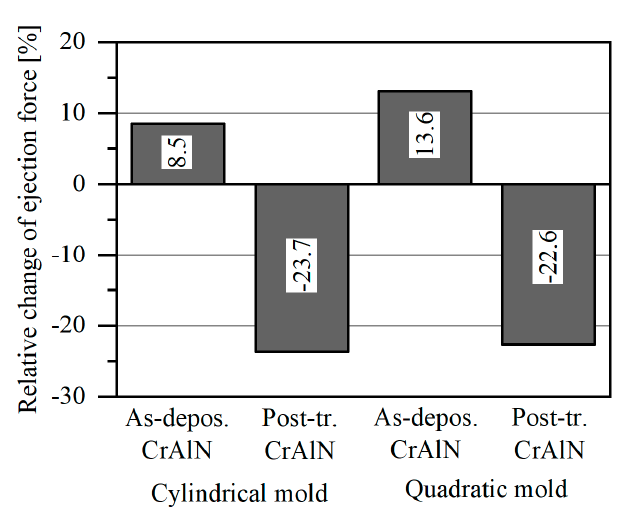
Figure 15. Relative change of the ejection forces by the as-deposited (as-depos.) and post-treated (post-tr.) CrAlN films compared to the polished reference surface.